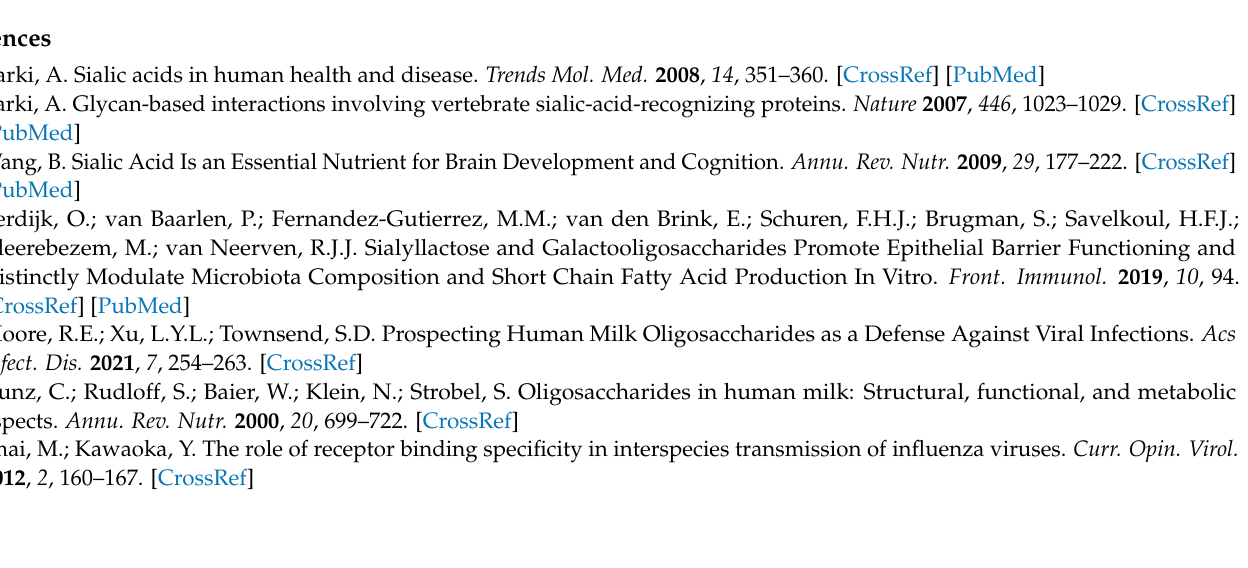
Figure S4. Analysis of α 2,3-sialidase activities of PMG2-1 and PMG2-2 by TLC. Figure S5. Analysis of α 2,3-sialyltransferase activities of PMG3-1 and PMG3-2 by TLC. Figure S6. Analysis of α 2,3- sialidase activities of PMG3-1 and PMG3-2 by TLC. Figure S7. SDS-PAGE analysis of overexpressed and purified PmST1 M144D. Figure S8. SDS-PAGE analysis of overexpressed and purified PMG1. Figure S9. SDS-PAGE analysis of overexpressed and purified PMG2. Figure S10. SDS-PAGE analysis of overexpressed and purified PMG3. Figure S11. SDS-PAGE analysis of overexpressed and purified PMG2-1. Figure S12. SDS-PAGE analysis of overexpressed and purified